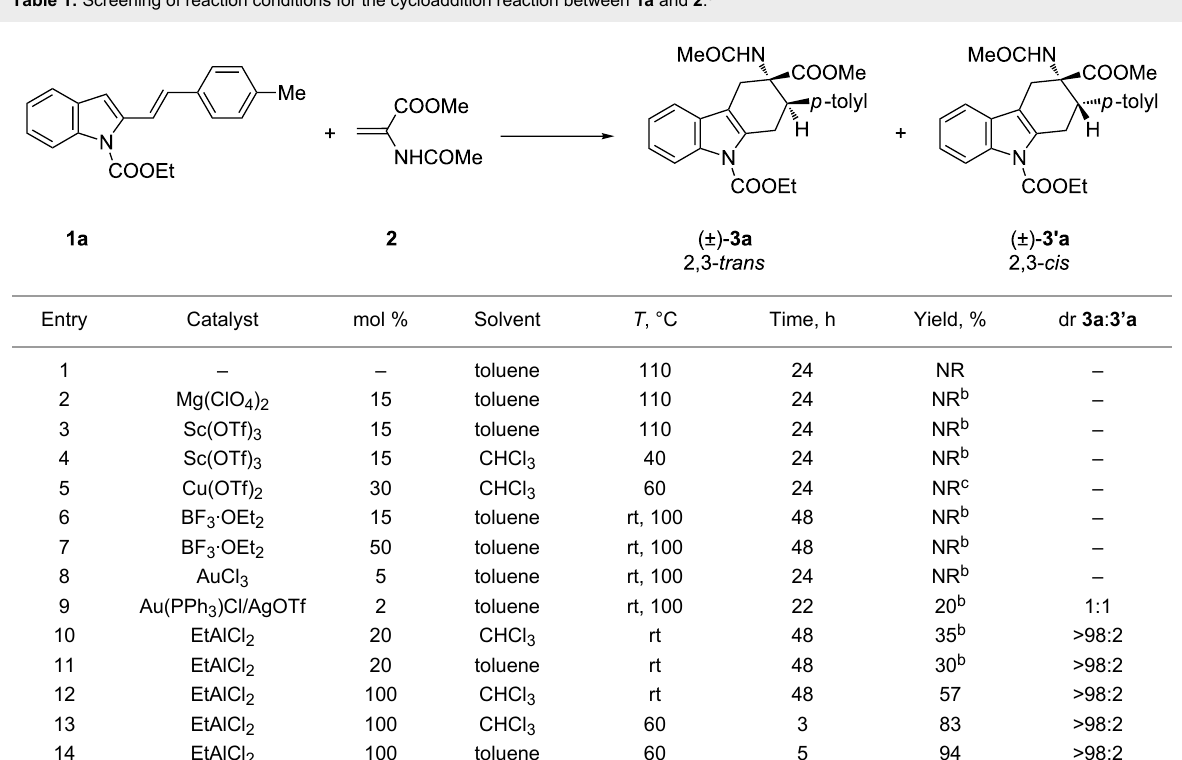
Table 1: Screening of reaction conditions for the cycloaddition reaction between 1a and 2 .